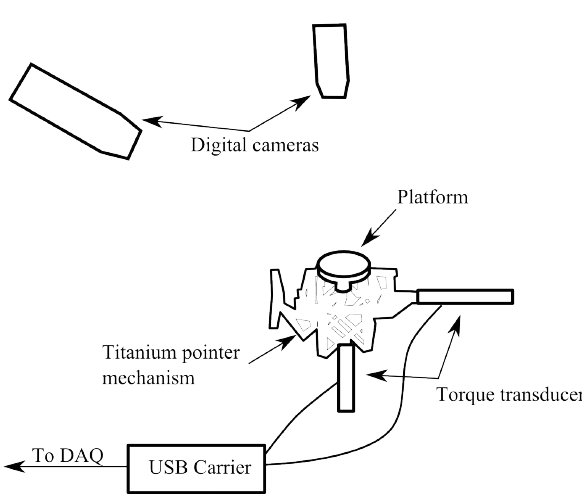
Figure 8. Test set-up for measuring applied torque and resulting displacement.